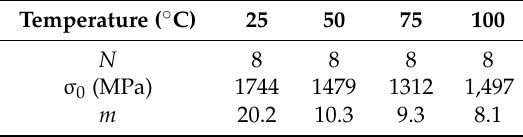
Table 3. Weibull parameters for tensile strength of glass yarn under different temperatures.